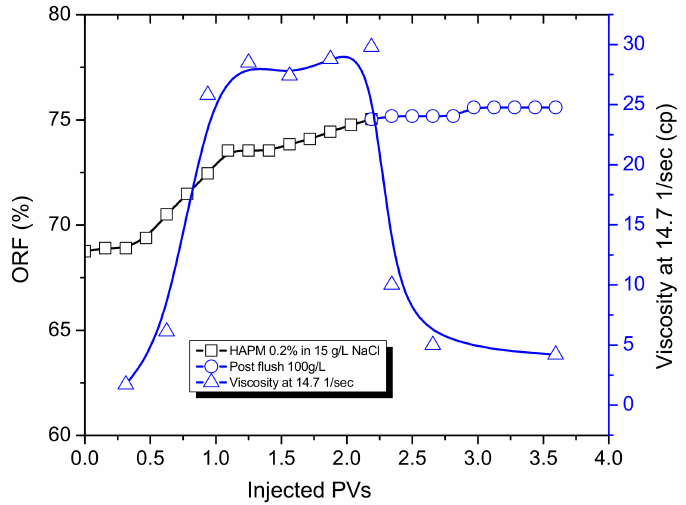
Figure 9. Viscosity of effluents and ORF versus injected PVs of HPAM solution. HPAM 0.2 wt.% with initial viscosity of 31 cp at 14.7 s − 1